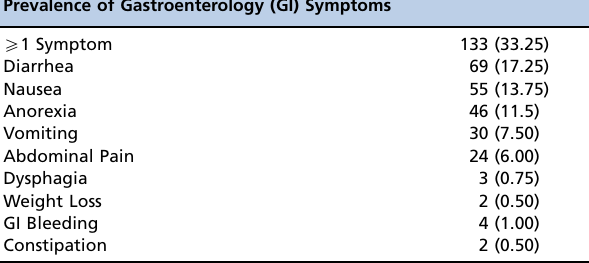
Table 2 - Prevalence of Gastrointestinal Symptoms at Time of Presentation Among Hospitalized Patients with